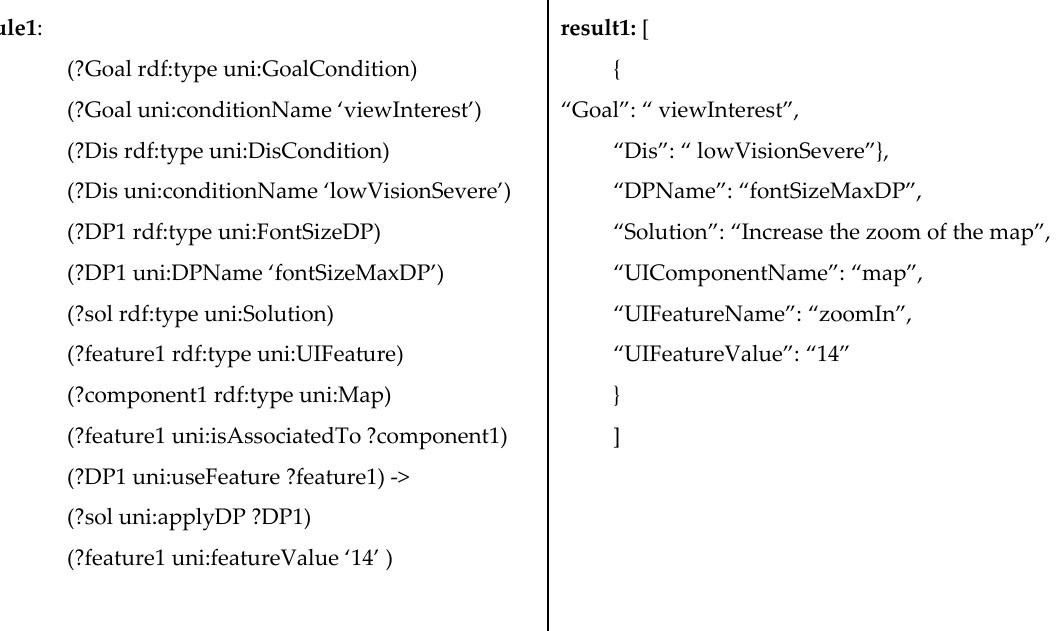
Figure 7. Example of adaptation rule.